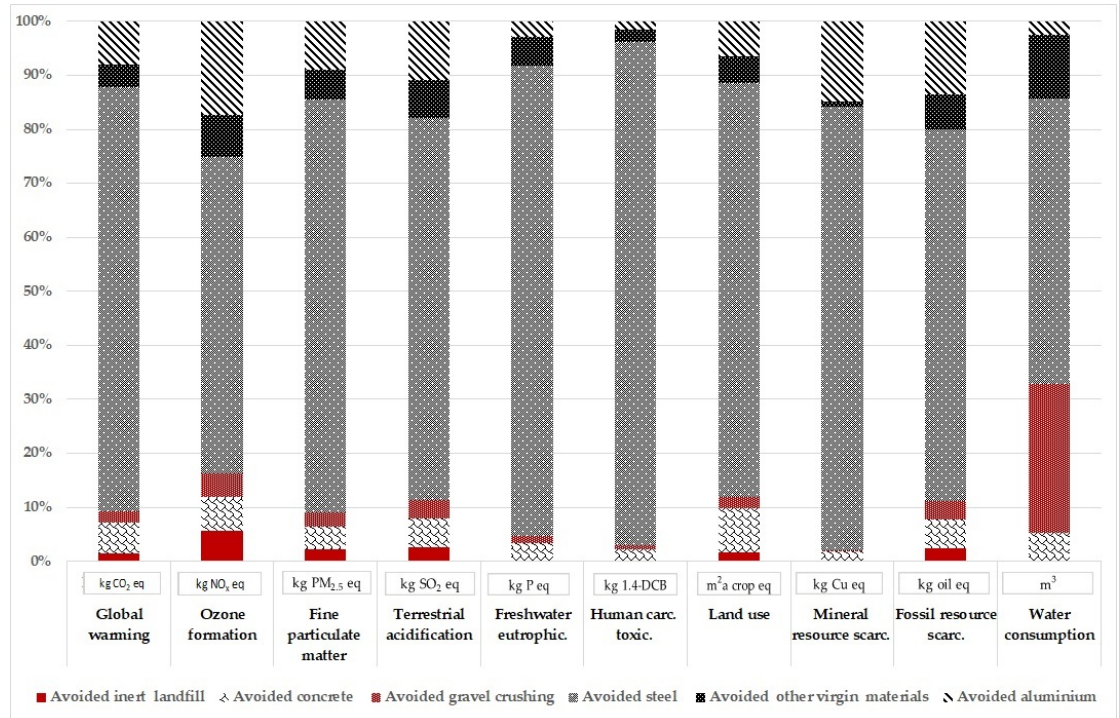
Figure 7 (with percentage values derived from Table 6) highlights very clearly the highest shares of avoided steel, aluminium and virgin materials production in all the environmental impact categories. Moreover, a non-negligible share results from avoided gravel crushing in the environmental category “water consumption”.